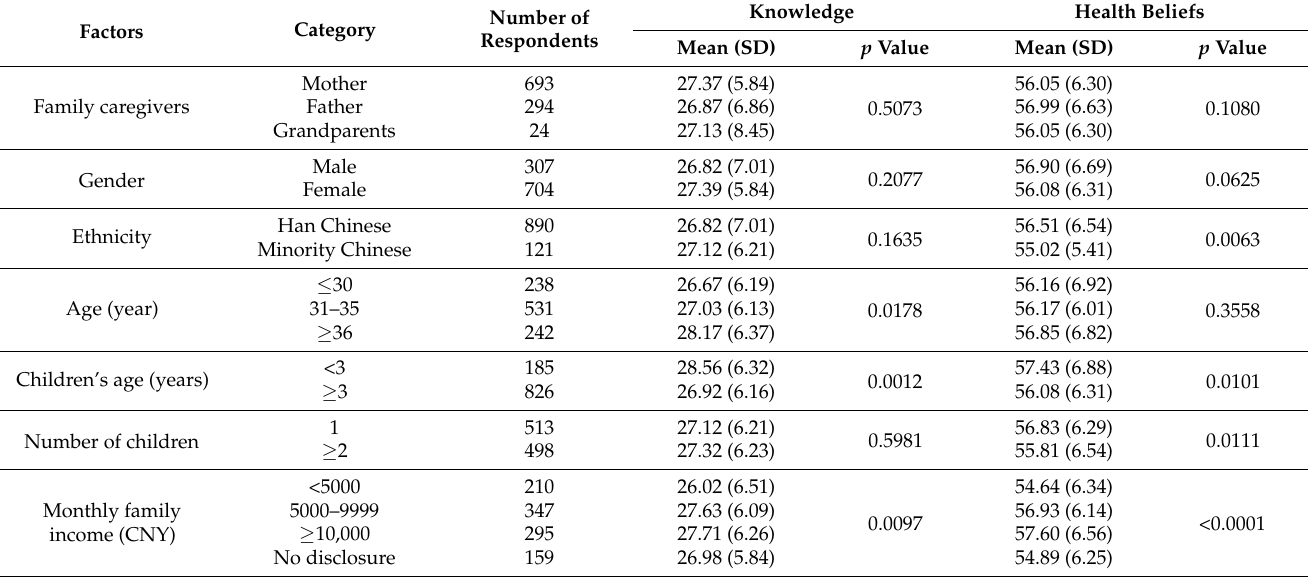
Figure 3. Responses to the health belief model (HBM) constructs. Overall, the mean score of knowledge was determined to be 27.22 (standard deviation, SD, 6.22) and the mean score of the health beliefs was 56.33 (SD, 6.43). The scores in both higher educational level, more history of communicable diseases in children, a higher uptake of MPSV/MPCV and four non-surrogate non-EPI vaccines, and was negatively associated with children’s age (each p < 0.05) (Table 3). Additionally, knowledge was significantly higher in the respondents of a senior age ( p = 0.0178), while the health beliefs were significantly higher in those who were Han Chinese ( p = 0.0063), had a single child ( p = 0.0111), and chose JEV ( p < 0.0001) (Table 3). Table 3. Scores of knowledge and health beliefs across the demographic groups, history of communi- cable diseases in children, and vaccine